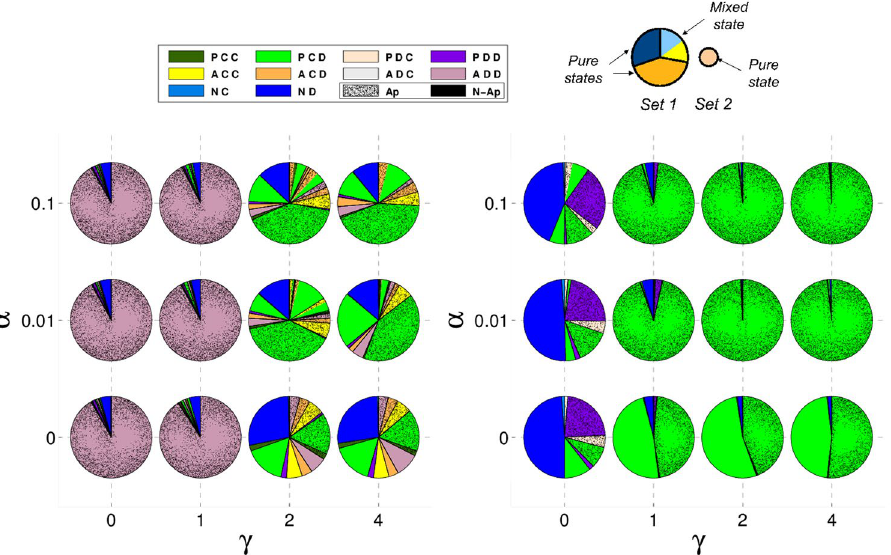
Figure 5. Acceptors reduce cooperation when an apology-forgiveness mechanism is introduced; defective acceptors take over the population when the apology cost is too low in RC games. Composition of the recurrent sets for RC repeated games with forgiveness. Same as Fig. 1 but for RC repeated games as a function of α and γ . Dotted (plain) sectors represent strategies that (do not) include apology. We assumed  = 0.25 and δ = 4.